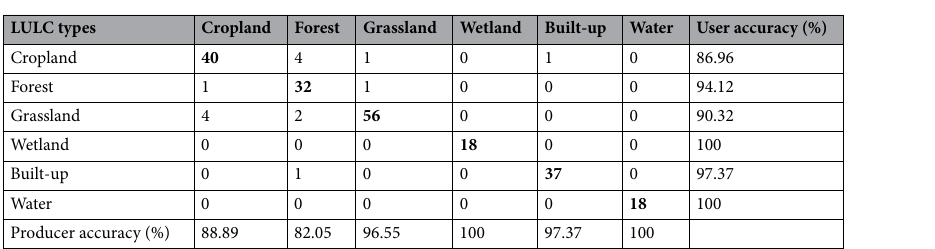
Table 4. Confusion matrices of LULC